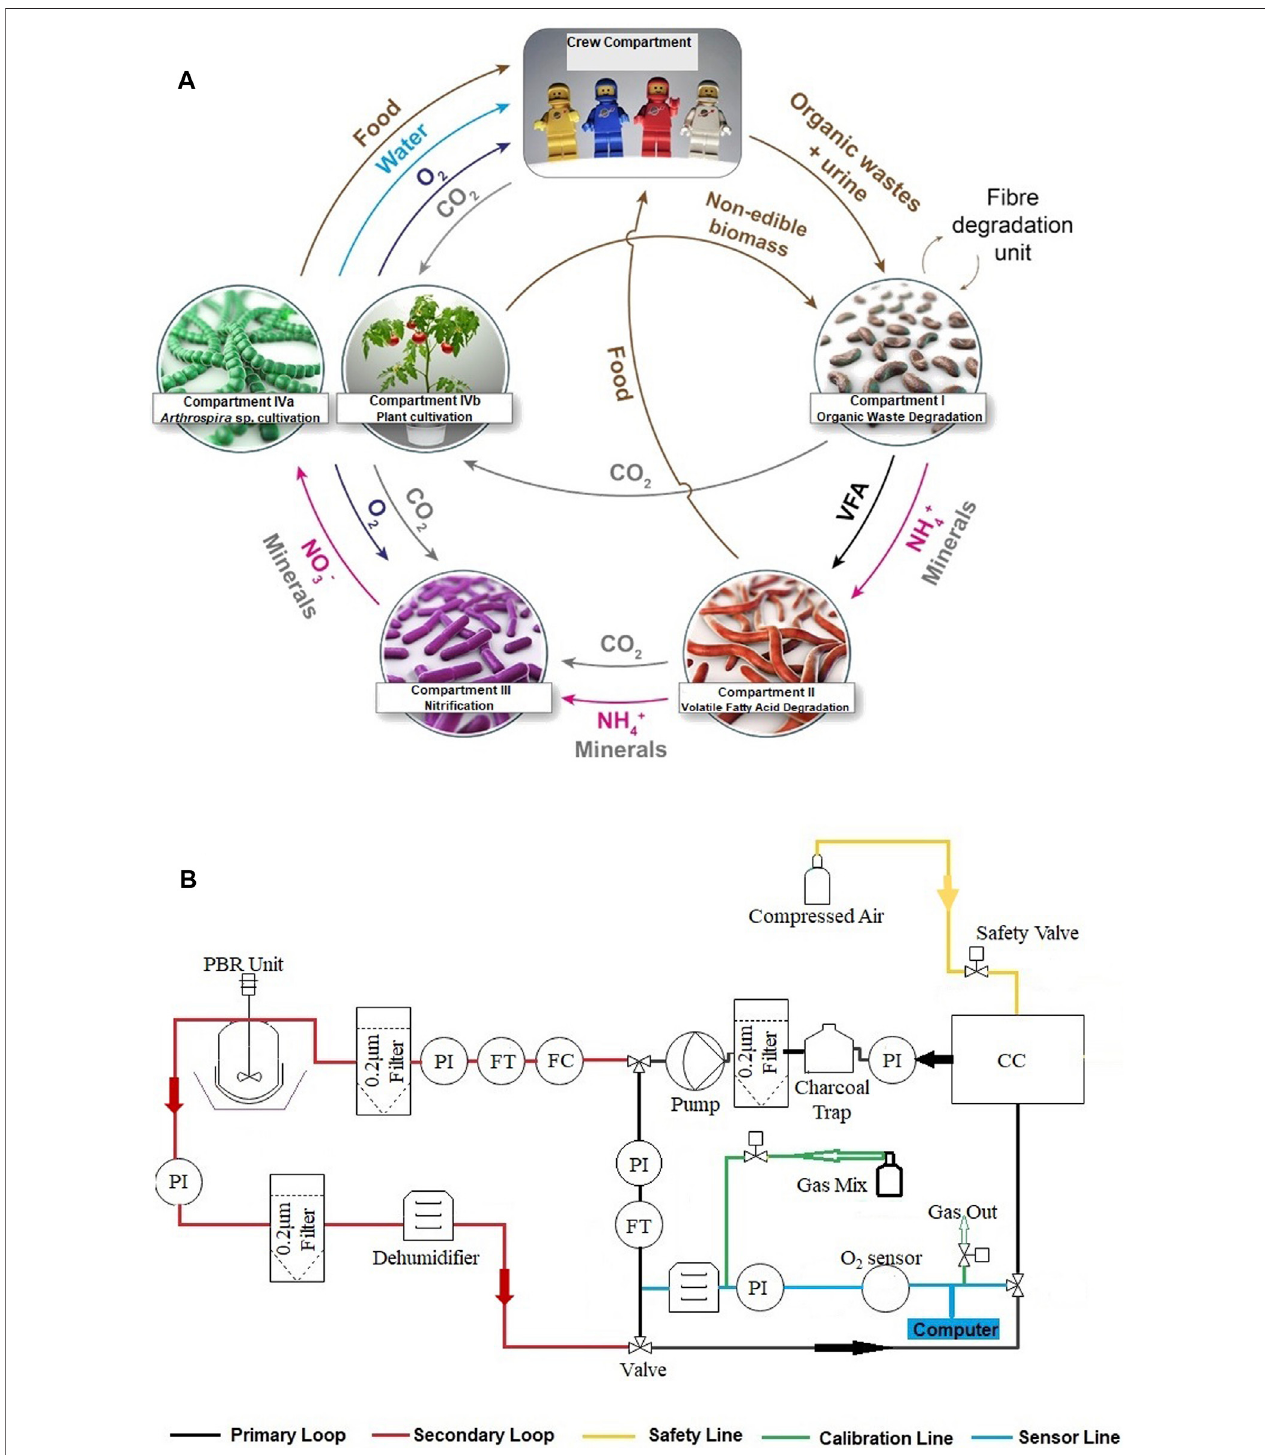
FIGURE 1 | (A) Schematic of the Micro Ecological Life Support System Alternative (MELiSSA) loop. (B) Schematic of the breadboard layout used for the ground demonstrationstudy.PBRunit, photobioreactor plus the lightening unit; PI,pressuremonitor; FT, fl owtransmitter;FC, fl owcontroller; CC, consumer compartment; O 2 , oxygen sensor.